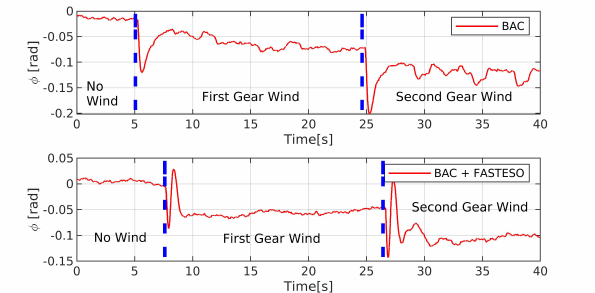
Figure 18. Experimental results of attitude with BAC and BAC+FASTESO under external wind.